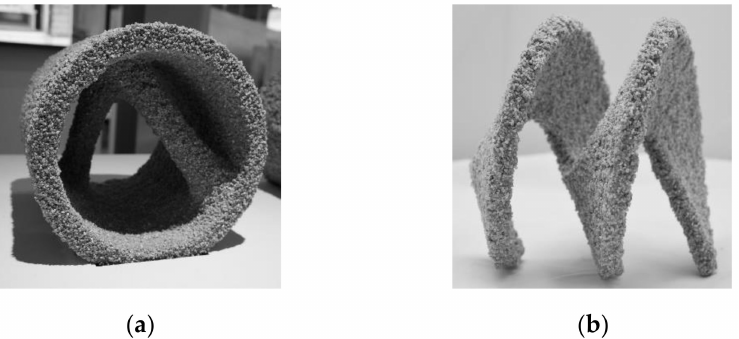
Figure 2. ( a ) SPI manufactured tube with internal double bracing; ( b ) SPI manufactured Helix (wing thickness 0.015 m); picture ( b ) C.